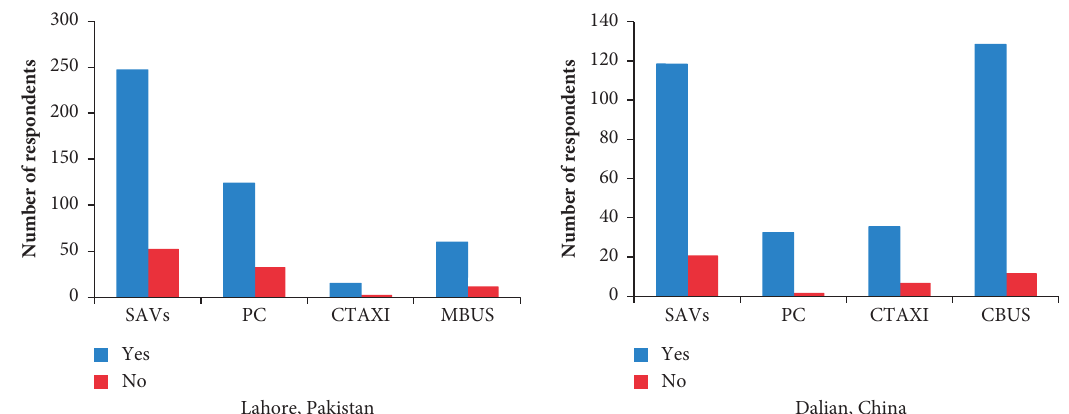
Figure 8: Preferences of shared mobility interested individuals to schooling and working trips.